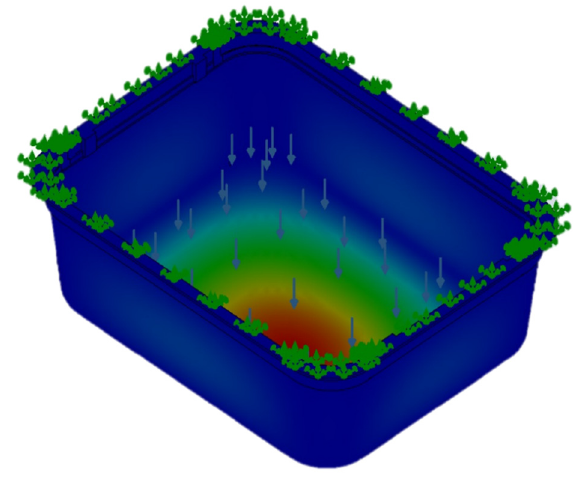
Figure 9. Example of the deformation results of the simulation in the food tray. Table 6. Simulation results for commercial materials.